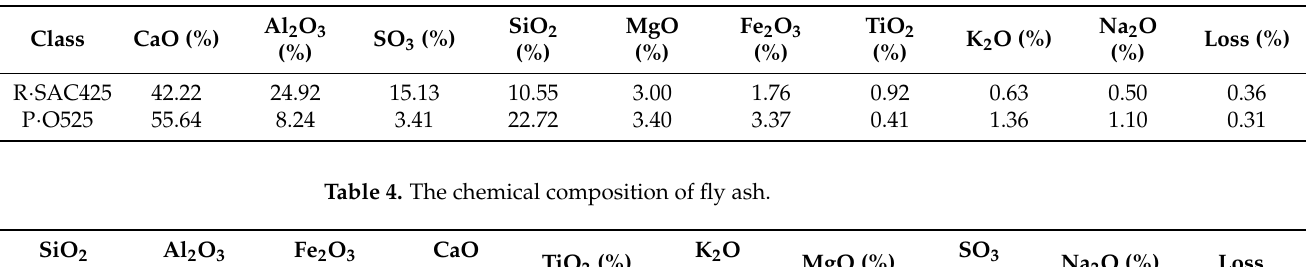
Table 3. The chemical composition of cement.